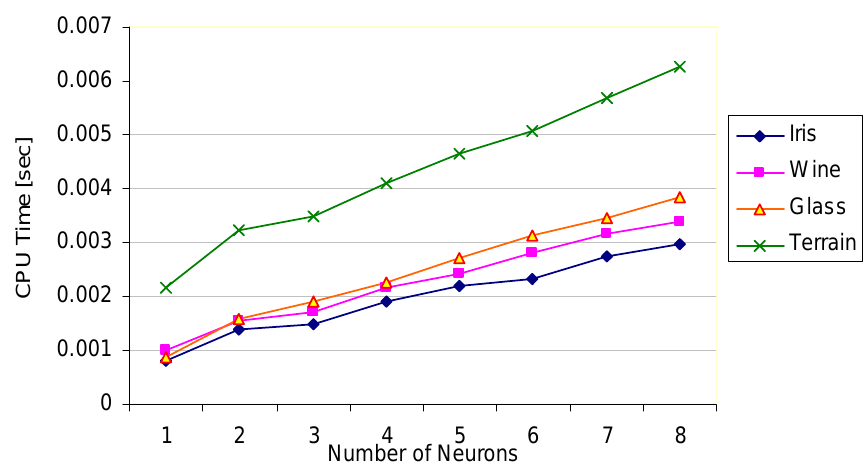
Figure 7. Evaluation CPU time of the RBF